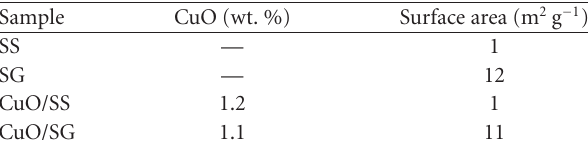
Table 2: Physicochemical properties of Sm 2 FeTaO 7 materials.